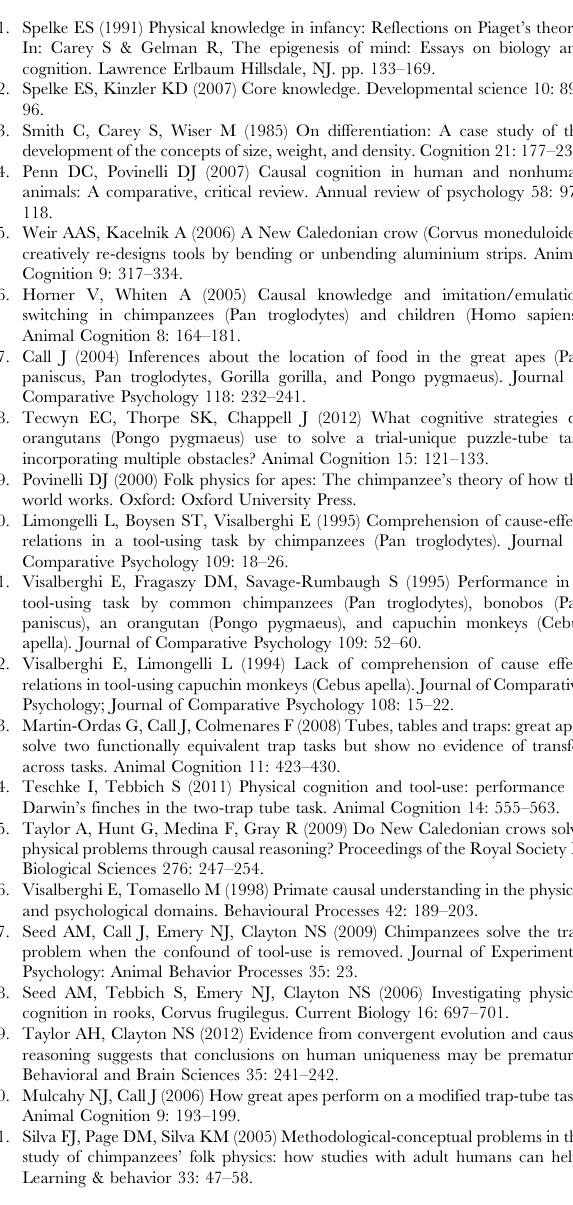
Figure S1 Diagrams of the training apparatus. Two apparatuses were used to train birds to drop stones down tubes. A: a baited platform – held in place with magnets – would collapse when a stone was dropped in the tube. B: a pivotal platform –